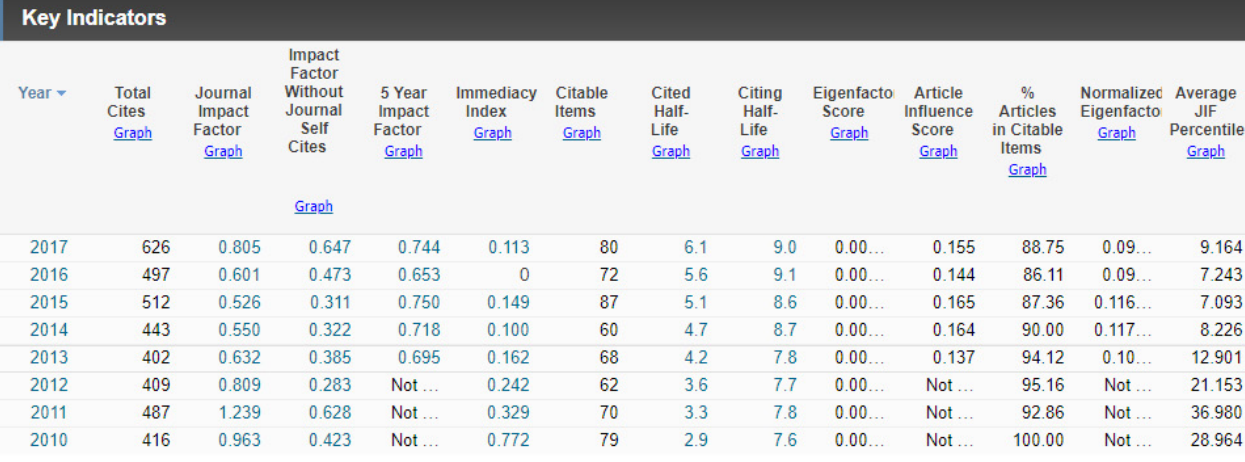
Fig. 1 - Latest impact factors of